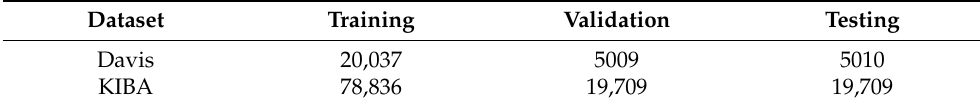
Table 2. Training, Validation and Testing